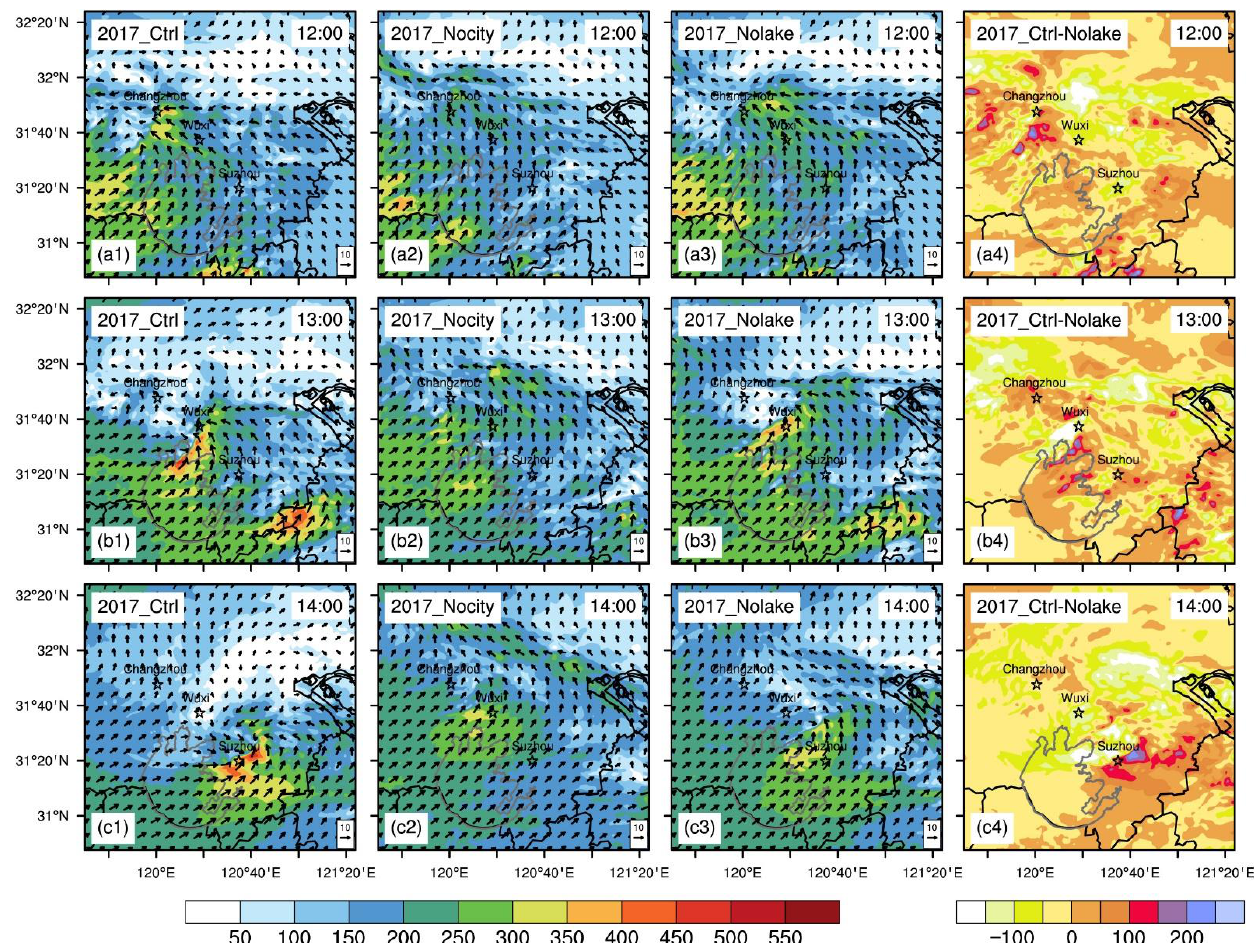
Figure 14. The spatial distributions of the water vapor fluxes (shaded, unit: kg m −1 s −1 ) integrated from 1000 hPa to 850 hPa and the mean horizontal wind directions (arrows, unit: m s −1 ) for the ( a1 , b1 , c1 ) control, ( a2 , b2 , c2 ) Nocity, ( a3 , b3 , c3 ) Nolake runs, and ( a4 , b4 , c4 ) the difference of water vapor fluxes between the control and Nolake runs for